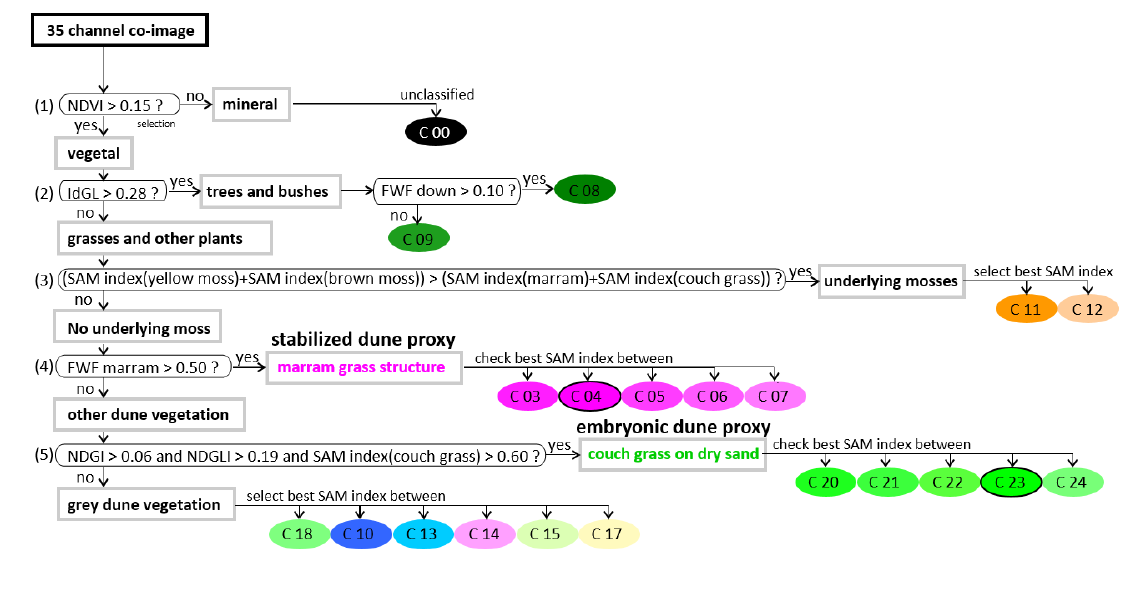
Figure 8. Decision tree used for the classification. The ellipses are the resulting vegetation groups with the color code used in Figures 11, 13a,b, 14a, 15a,b and